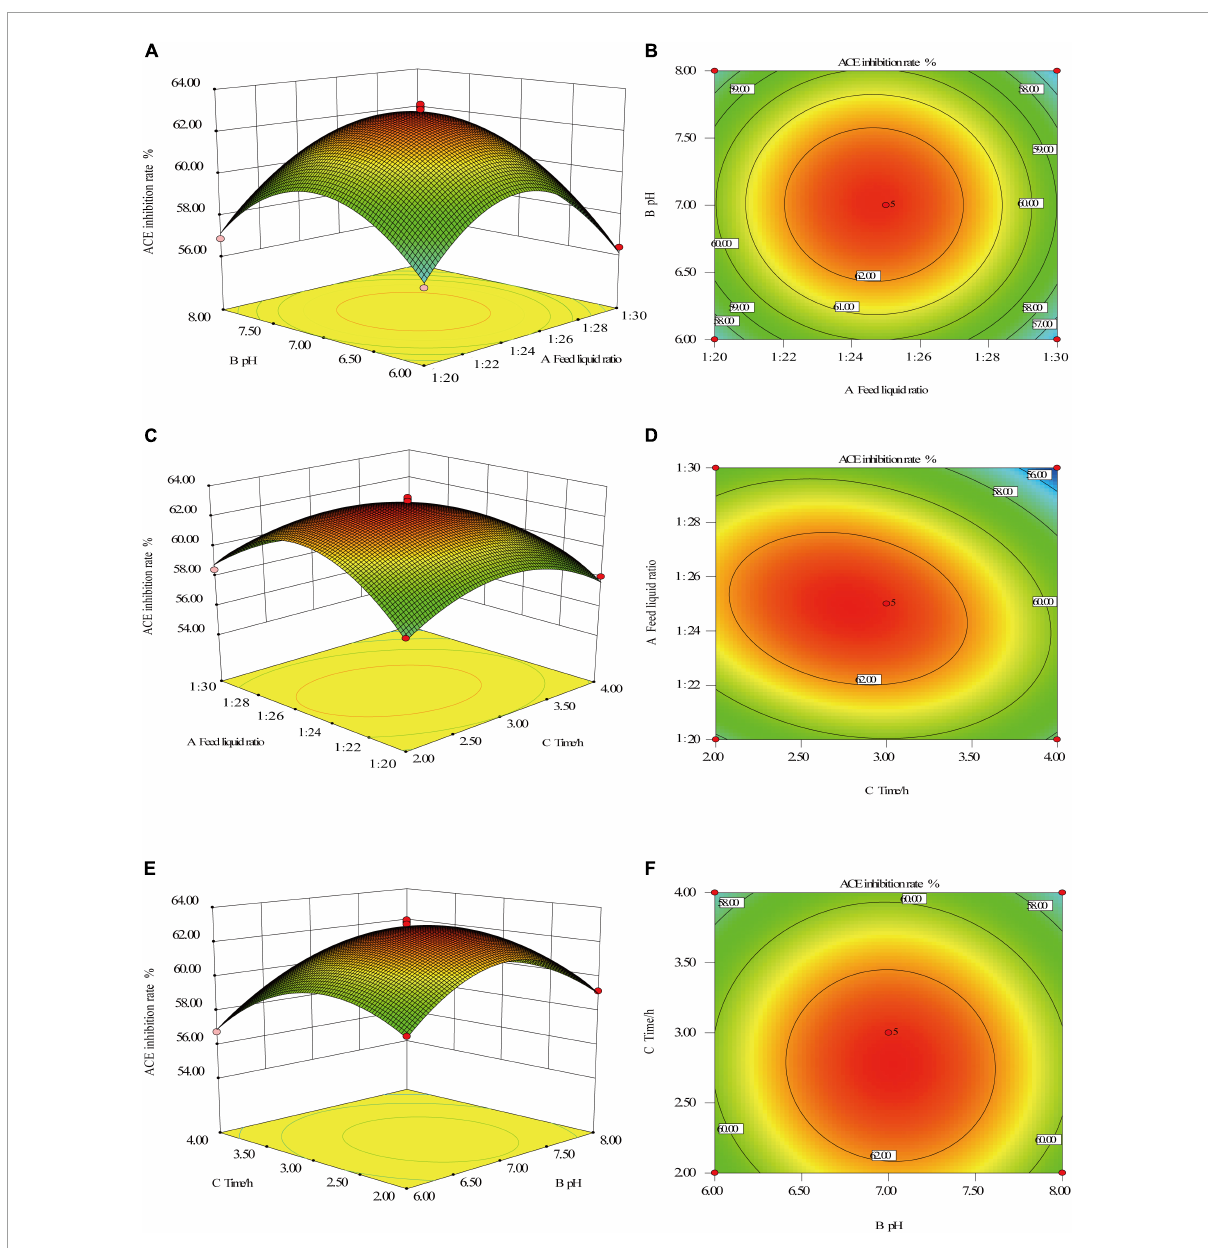
FIGURE3 Response surface intuitive diagram of the interaction between factors. Feed liquid ratio and pH (A,B) , Feed liquid ratio and enzymolysis time (C,D) , and pH and enzymolysis time (E,F)